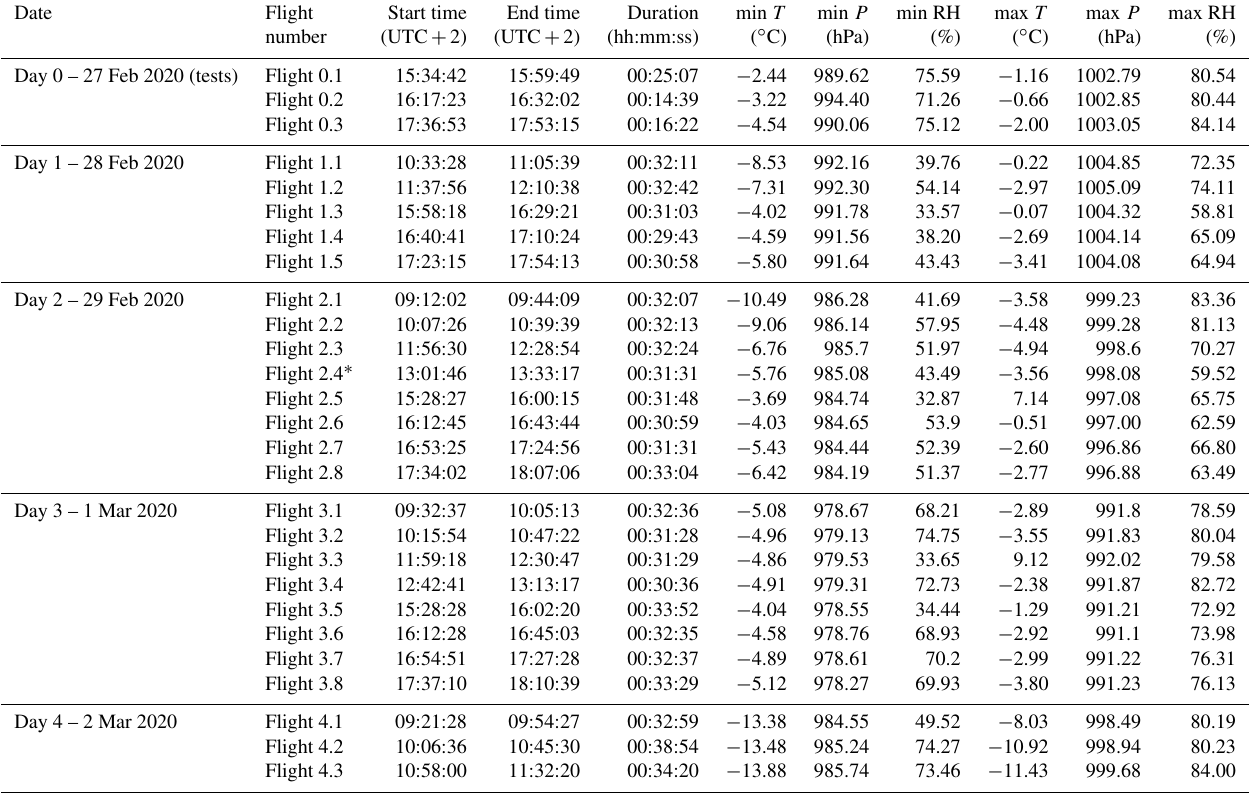
Table 1. Meteorological flights performed by UAV-UG1 with minimum and maximum values of measured